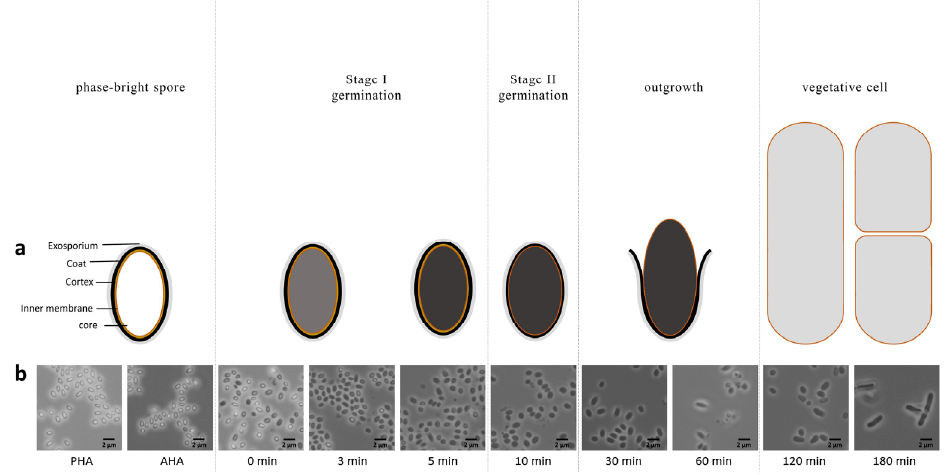
Figure 1. Scheme of spore germination and outgrowth ( a ). Morphological changes taking place during spore germination and outgrowth, as seen by microscopy ( b ). Spore samples were harvested at different time points throughout germination and outgrowth, and were imaged by phase contrast microscopy. PHA, pre-heat activation; AHA, after heat activation.